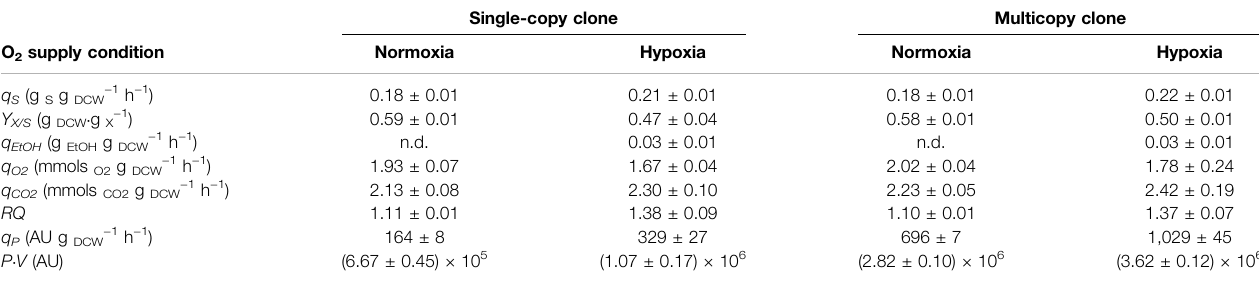
TABLE 1 | Averaged value of key process parameters obtained in fed-batch fermentations. Speci fi c substrate consumption rate ( q S ), biomass-to-substrate yield ( Y X/S ), speci fi cethanolproductionrate(